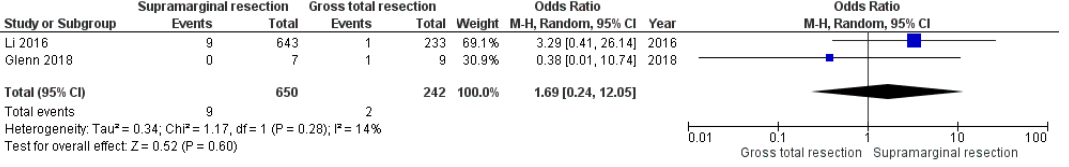
Figure 5. Forest plot displaying odds ratio and 95% CI estimates for postoperative intracranial hemorrhage in studies [24,32] evaluating SMR compared to GTR in GB patients. X-axis locations of squares represent the odds ratio; the bigger the square, the greater the weight due to sample size. The diamond corresponds to the odds ratio of the overall data.